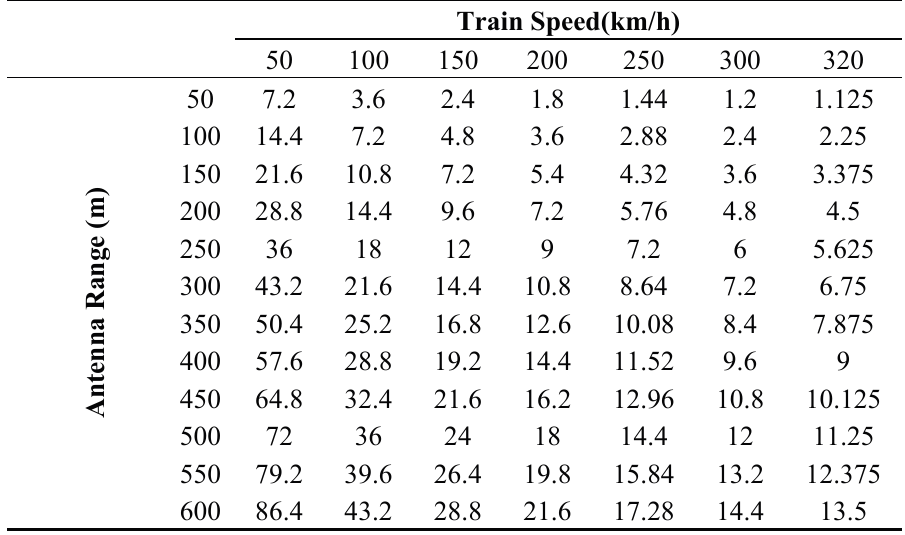
Table 1. Time (s) two antennas can communicate assuming one of them is placed in a